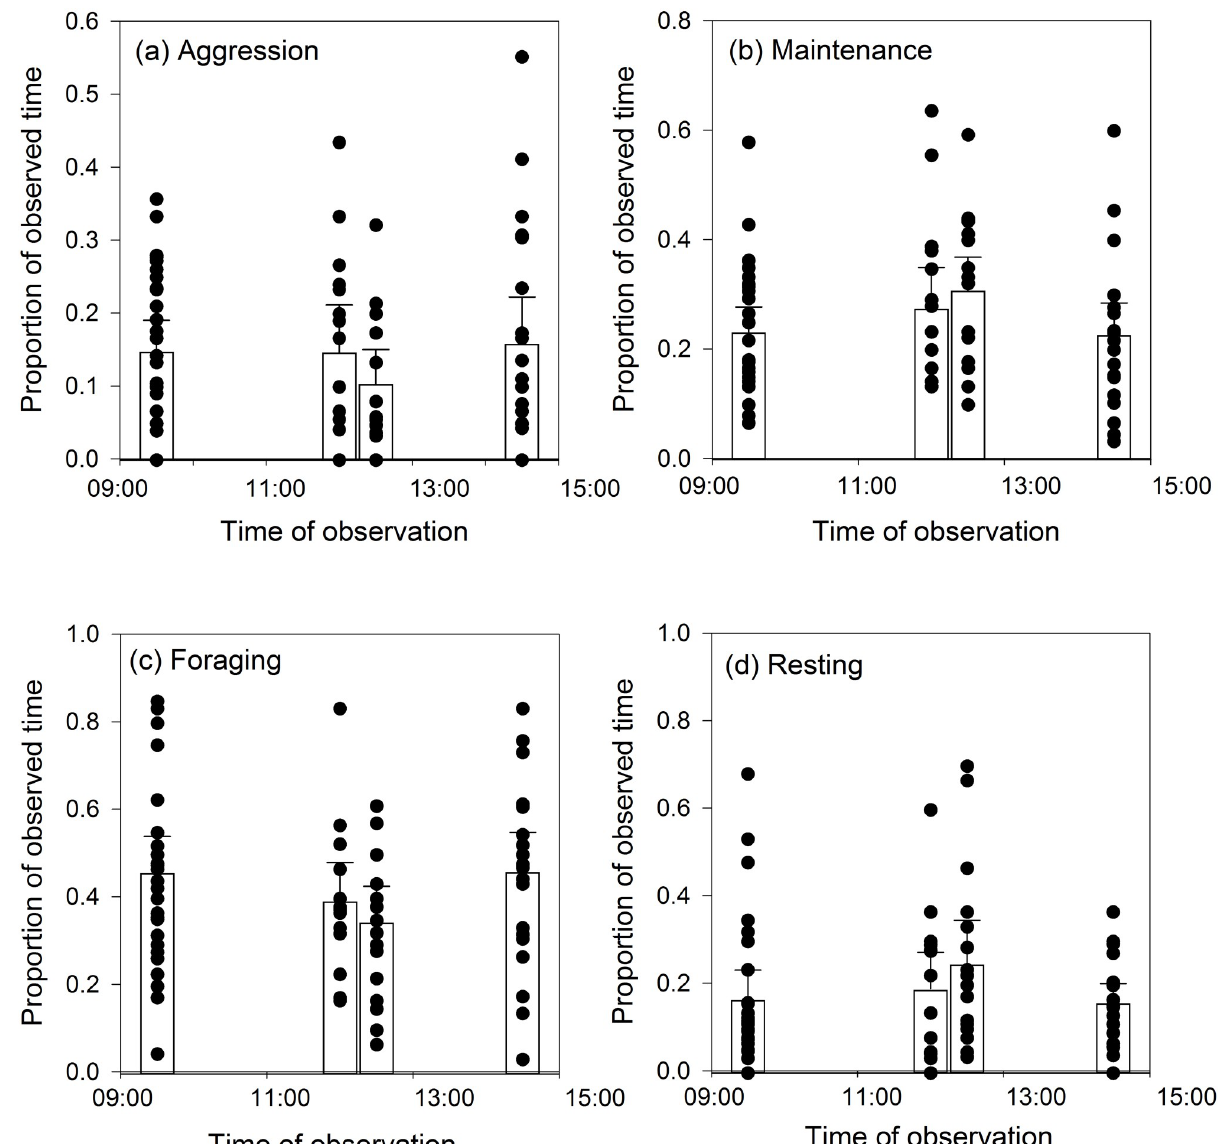
Fig 2. Observed mute swan behaviour at different times of day. The bars represent the mean ± 95% CI time spent on each behaviour, whilst the filled circles represent the individual data points.